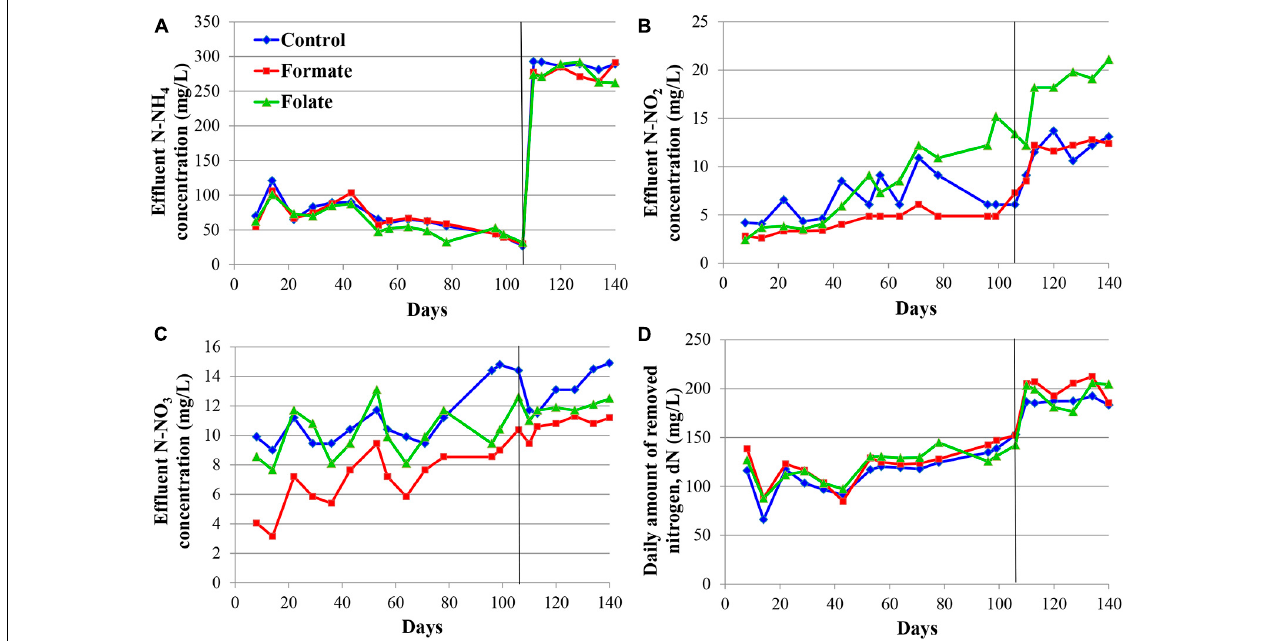
FIGURE 5 | Dynamics of the concentrations of nitrogen compounds in the effluent during the second run of the reactors (milligrams per liter): concentrations of N–NH 4 (A) , N–NO 2 (B) , N–NO 3 (C) , and daily amount of removed nitrogen (dN) (D) . A black vertical line separates periods before and after the ammonium load increased.